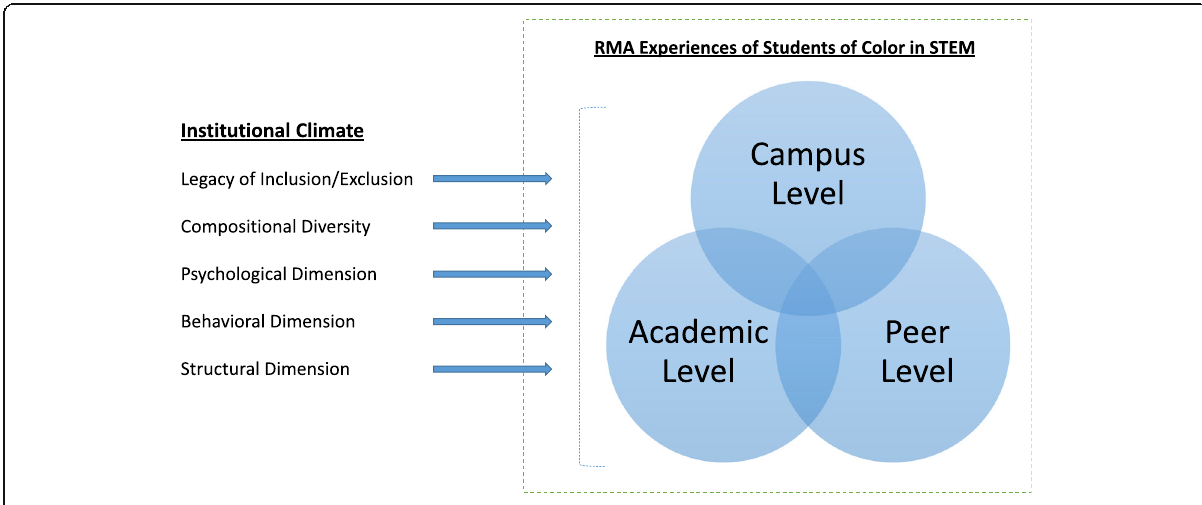
Fig. 1 Campus racial climate and racial